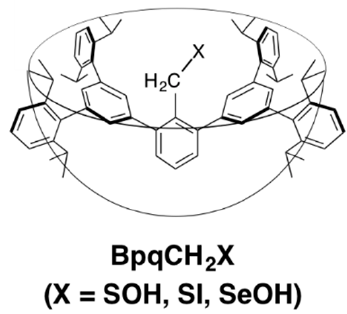
Figure 1. Reactive species stabilized by a cavity-shaped primary-alkyl steric protection group.